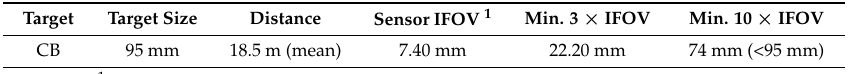
Table 8. Facade target distance and IFOV to satisfy minimum target size requirement.